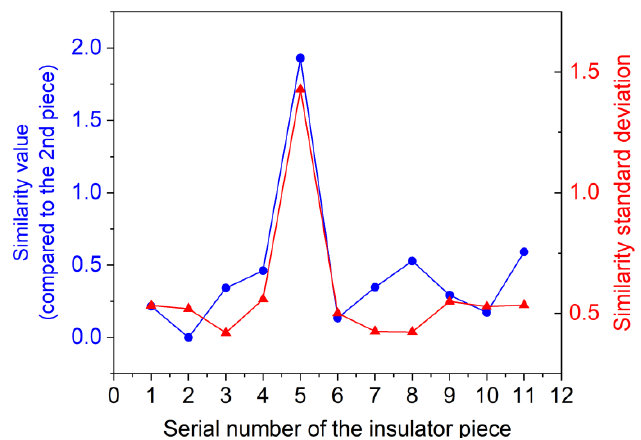
Figure 13. Similarity standard deviation and similarity value between pieces of damaged insulator shown in Figure 11b.